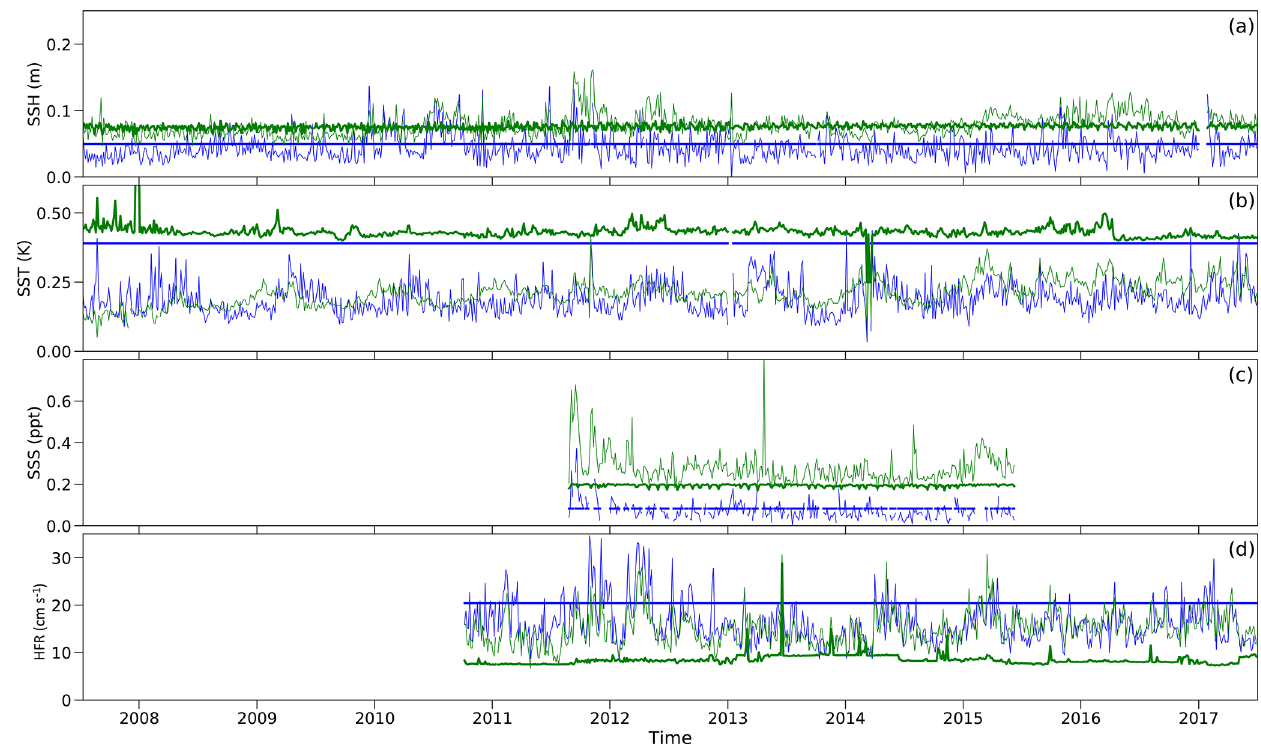
Figure 6. Time series of spatially averaged background (blue) and observation (green) errors, with thick lines showing a priori values and thin lines the posterior calculated using Eqs. (5) and (7). (a) Sea surface height; (b) sea surface temperature; (c) sea surface salinity; and (d)